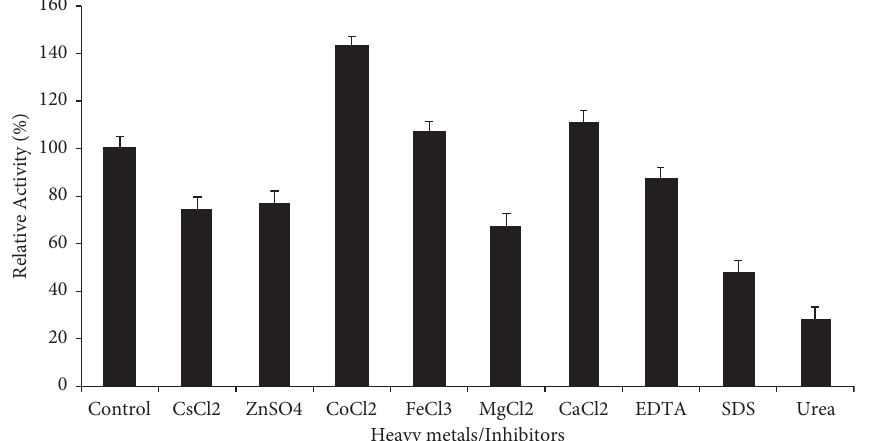
Figure 2: Effect of heavy metals/inhibitors on the alpha-amylase activity.